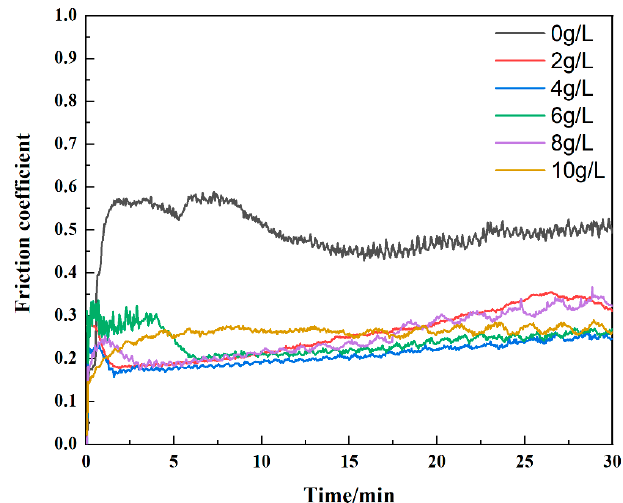
Figure 4. Wear curves of MAO-treated titanium alloys doped with CuSO 4 at various concentrations.